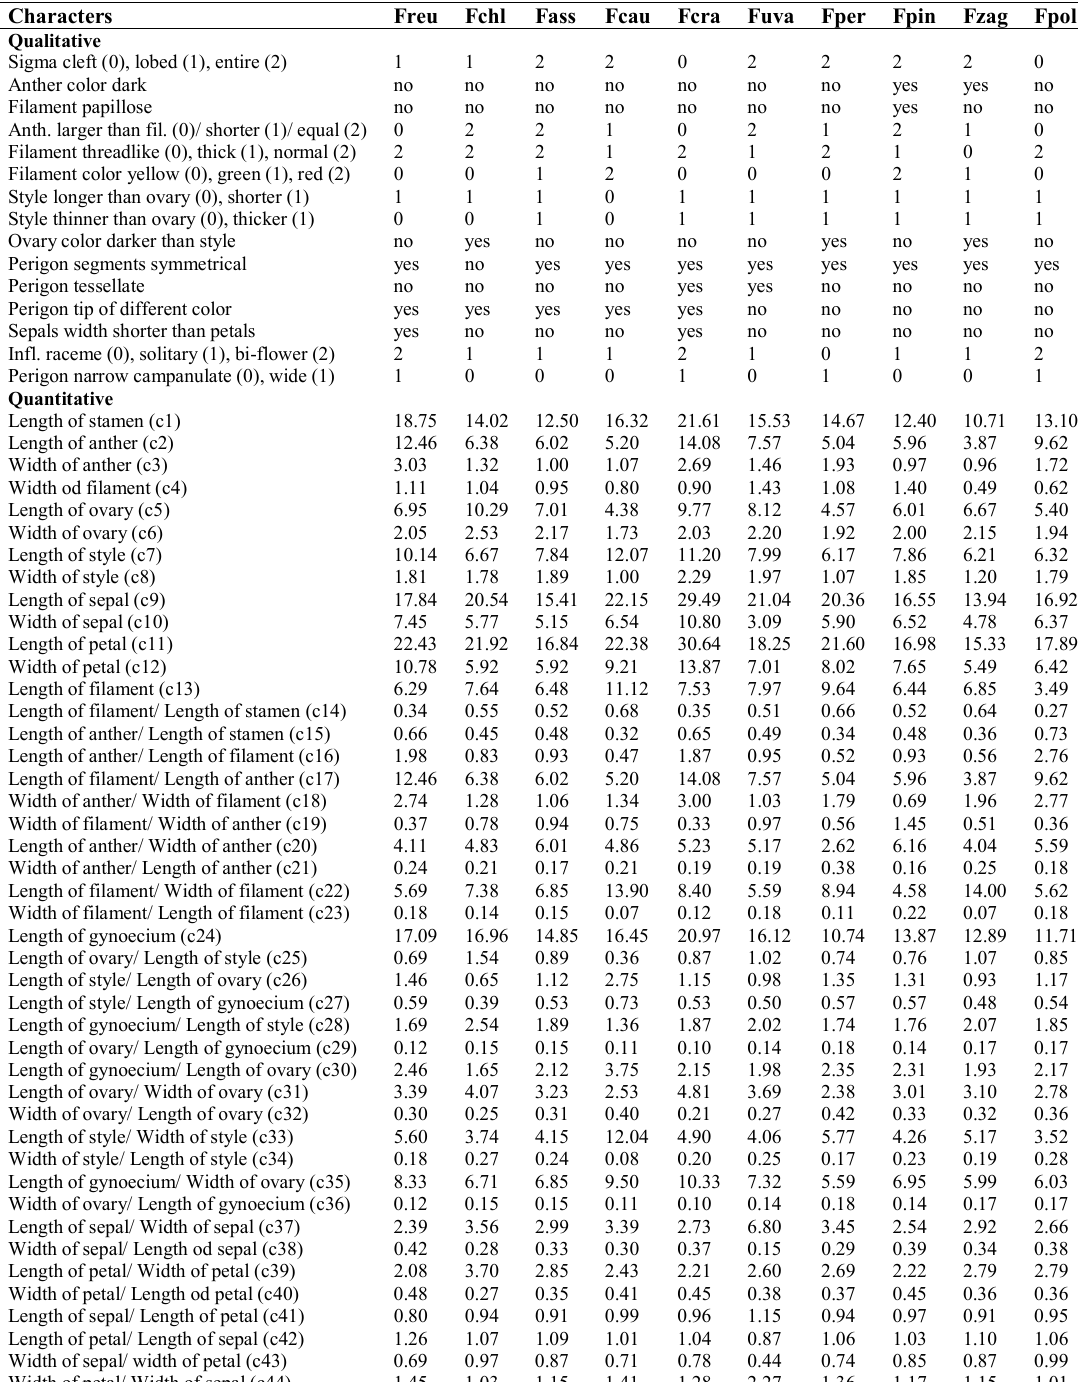
Table 2. Qualitative and quantitative morphological characters observed/measured on specimens. Qualitative (0/1) characters are shown as 15 multistate characters. Freu: F. reuteri , Fchl: F. chlorantha , Fass: F. assyriaca , Fcau: F. caucasica , Fcra: F. crassifolia ssp. kurdica , Fuva: F. uva-vulpis , Fper: F. persica , Fpin: F. pinardii , Fzag: F. zagrica , Fpol: F. poluninii Characters